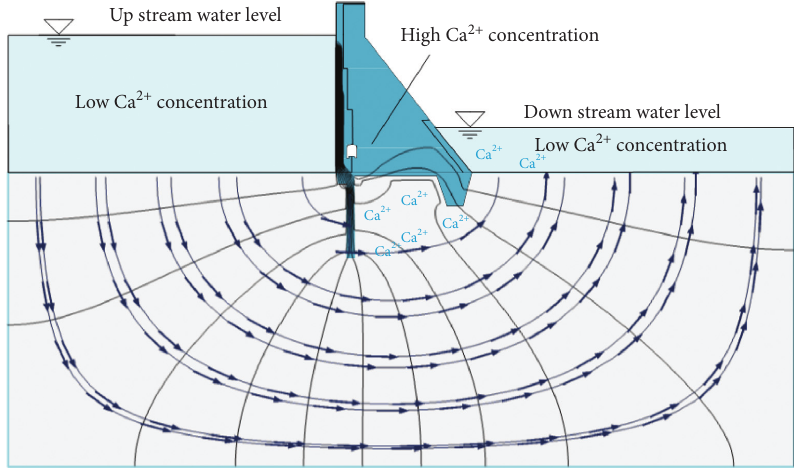
Figure 1: General sketch of the physical model for calcium leaching in concrete gravity dam.